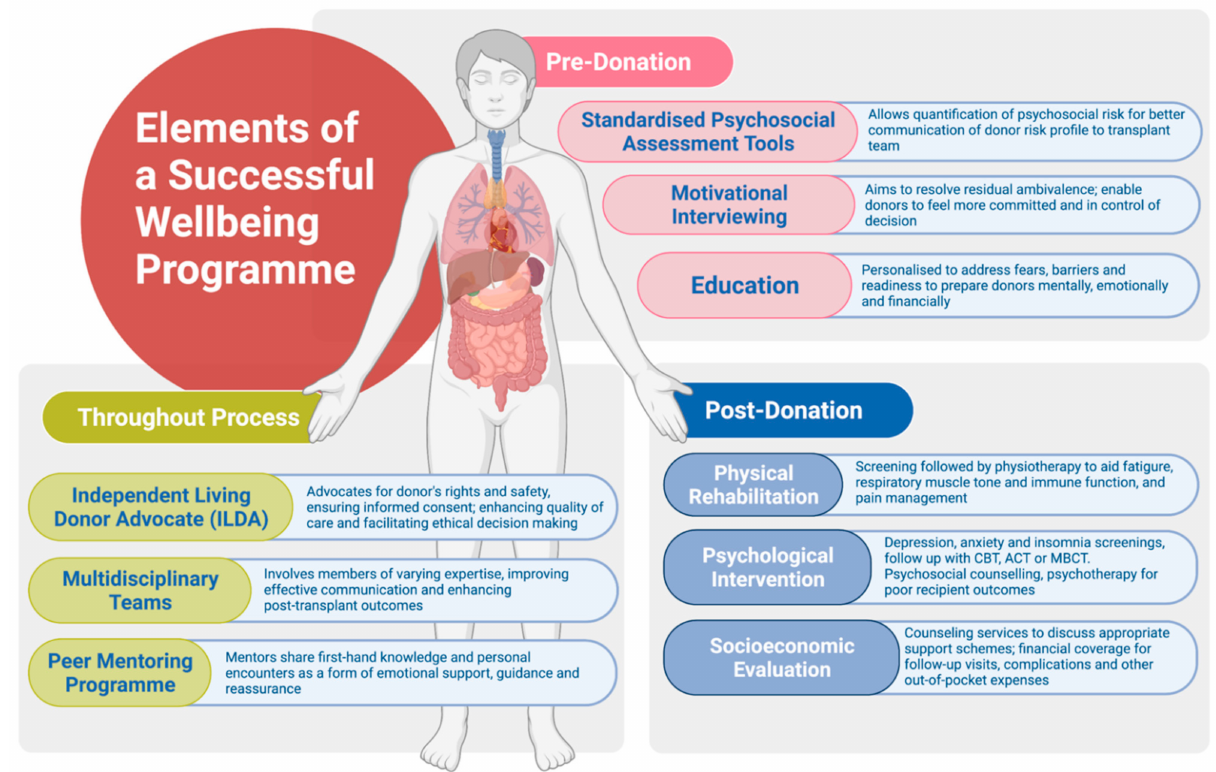
Figure 2. Elements of a Successful Wellbeing